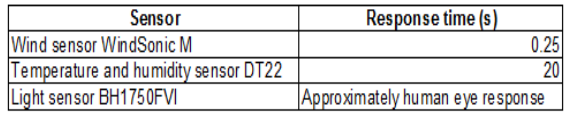
Figure 19. Responsetimesofsensorsin a light trap sensornode rate, the frequency 433Mhz. Assume that the board is configured to work with 11kbps data rate.